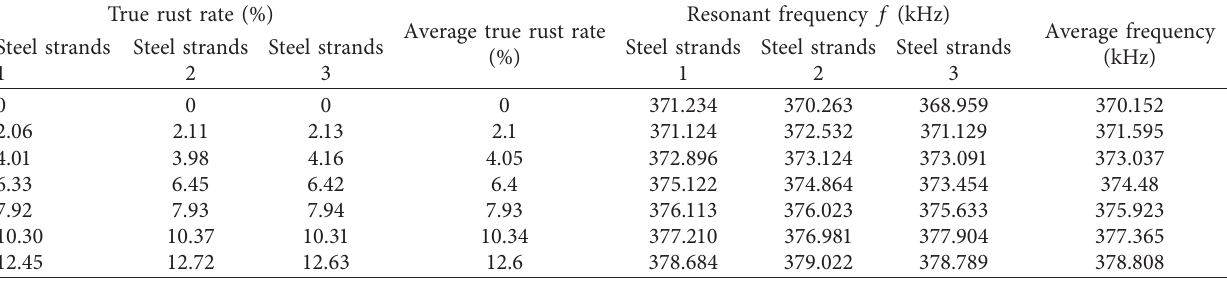
Table 3: Test data of the first group of steel strands.